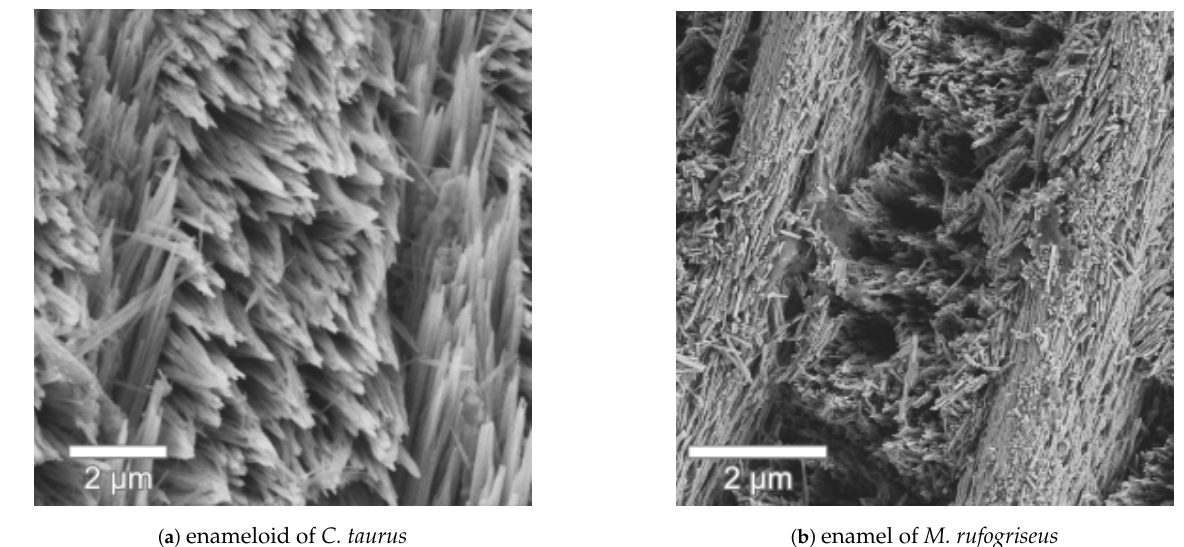
Figure 9. Transversal sections of ( a ) the outer enameloid of C. taurus and ( b ) the modified radial enamel in a tooth of Macropus rufogriseus (red-necked wallaby). Both species exhibit radial sheets of densely packed crystallites separating rows of bundled crystallites. The hydroxyapatite crystallites of the mammalian enamel are thinner than the fluorapatite of enameloid but the higher-level bundles and radial elements have the same size in both tissues. Despite the significant size difference between the two species, the imaged teeth are of similar size with a crown height of 10mm in C. taurus and ca. 7mm in M. rufogriseus